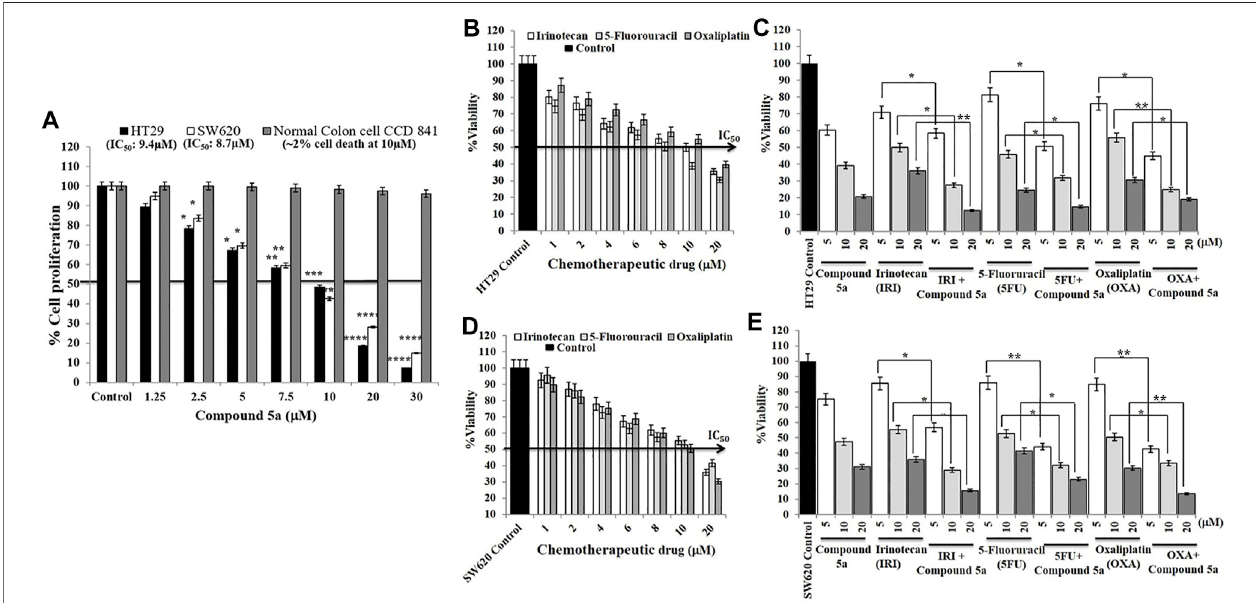
FIGURE7| Compound5adecreasesHT29 andSW620cellviabilitywithoutaffectingtheviabilityofnormalcolonepithelialCCD841cellsandenhancesirinotecan (IRI), 5- fl uorouracil (5-FU), and oxaliplatin (OXA) cytotoxic effects on HT29 and SW620 cells. (A) HT29, SW620, and the normal colon epithelial CCD 841 cell lines were exposed to different concentrations (5-10-20 μ M) of Compound 5a for 24 h. Cell viability was measured by the MTT assay at 540 nm regarding the cellular metabolic activity.Bargraphshowingthecellviabilitypercentage andthedataareexpressed asmean±SD( n =3).*** p < 0.001and**** p < 0.0001 vs .Control.Half-maximal inhibitory concentrations (IC50) of Compound 5a on HT29 and SW620 cell viability were determined. HT29 (B,C) and SW620 (D,E) cells were treated with different concentrationsofthechemotherapeuticdrugsIRI,5-FU,andOXAfor24 hinthepresence (C,E) orabsence (B,D) ofvariousconcentrations(5-10-20 μ